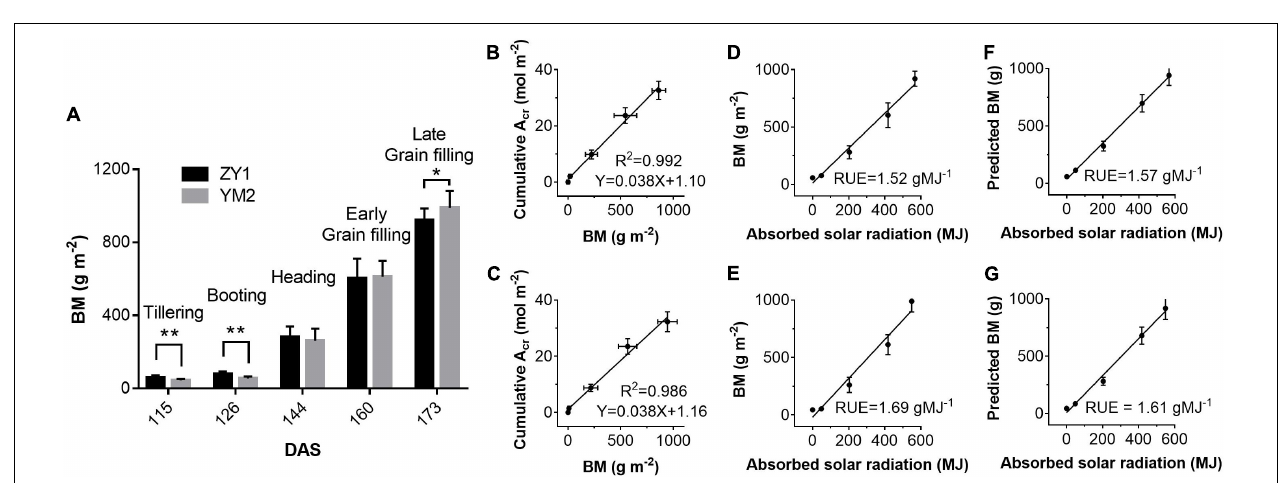
FIGURE 7 | The relationship between energy conversion efficiency ( ε c ) and daily total photosynthetically active radiation (PAR d ) for ZY1 (A–E) and YM2 (F–J) . The shape of data points represents different developmental stages. The data of all the four stages were shown together (A,F) and shown separately for booting (B,G) , heading (C,H) , early grain filling (D,I) , and late grain filling (E,J) stages.